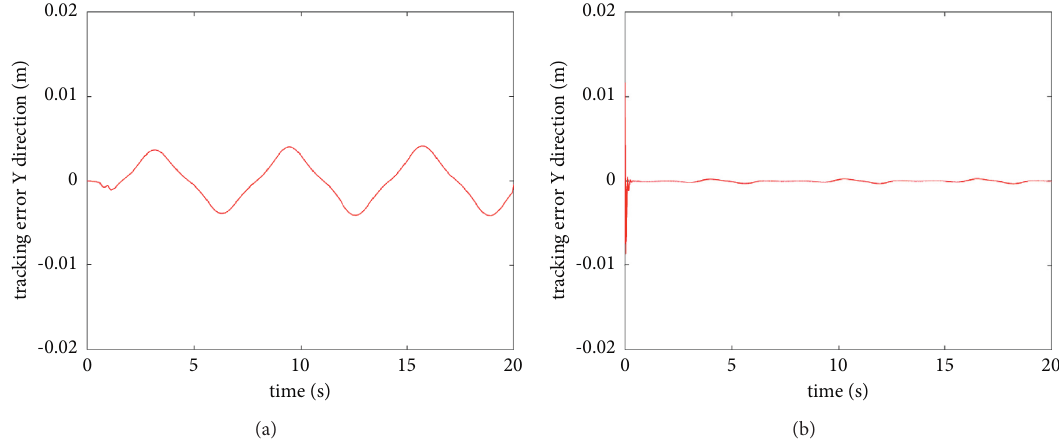
Figure 9: The trajectory tracking error of work platform in y direction under the action of (a) backstepping control and (b) NN-based backstepping